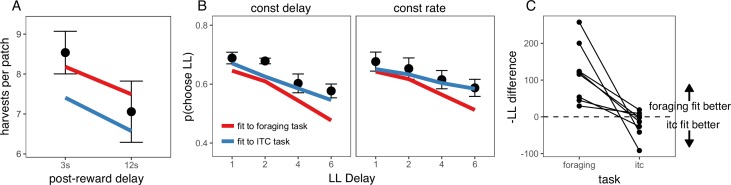
Cross-task model predictions.(A) Predicted foraging behavior for quasi-hyperbolic model parameters fit to either the foraging task (red line) or delay discounting task (DD; blue line). Black points and error bars represent mean ± standard error of rat data. (B) Predicted intertemporal choice behavior for quasi-hyperbolic model parameters fit to data from either the foraging or delay discounting task, plotted against rat behavior. (C) The difference in negative log likelihood of the left out sample of foraging data (left) or intertemporal choice data (right) between parameters fit to the intertemporal choice task and parameters fit to the foraging task. A negative -LL difference indicates the negative log likelihood of the data for parameters fit to the intertemporal choice task was lower than for parameters fit to the foraging task. Each point and line represents data from individual rats.